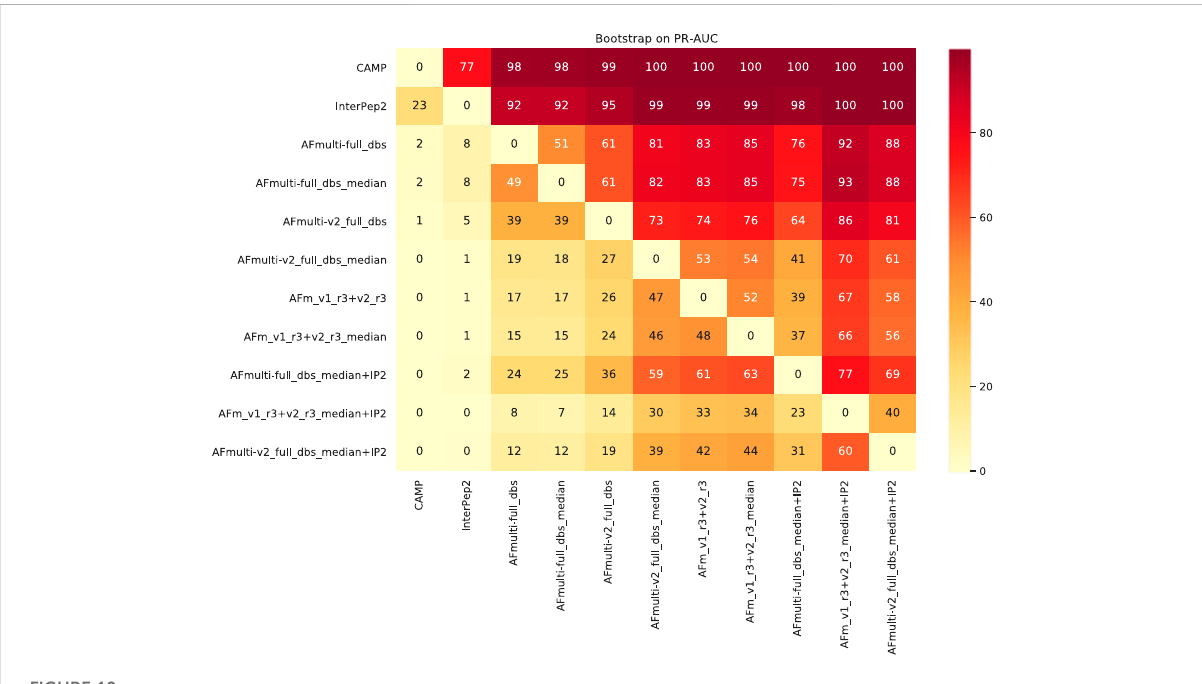
FIGURE 10 Pairwise bootstrap values on PR-AUC, corresponding to the percentage of times the method on the X -axis has a higher PR-AUC than the method on the Y -axis when sampling the data with replacement ( n =